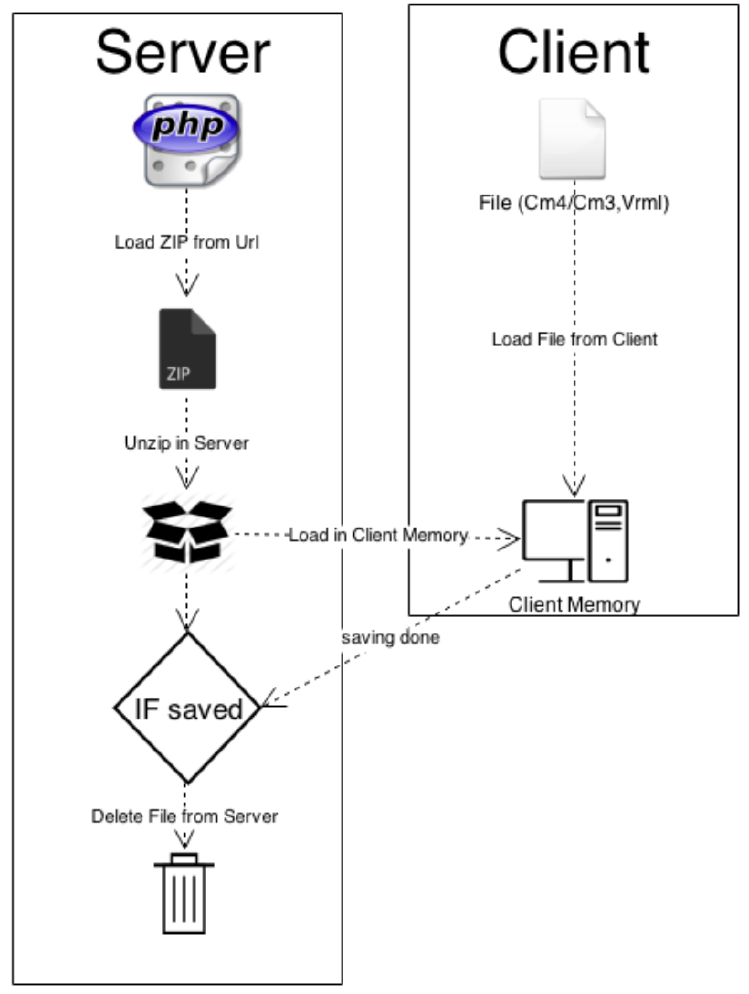
Figure 2: Server-Client approach during loading: loading of online-available files (left) and local files